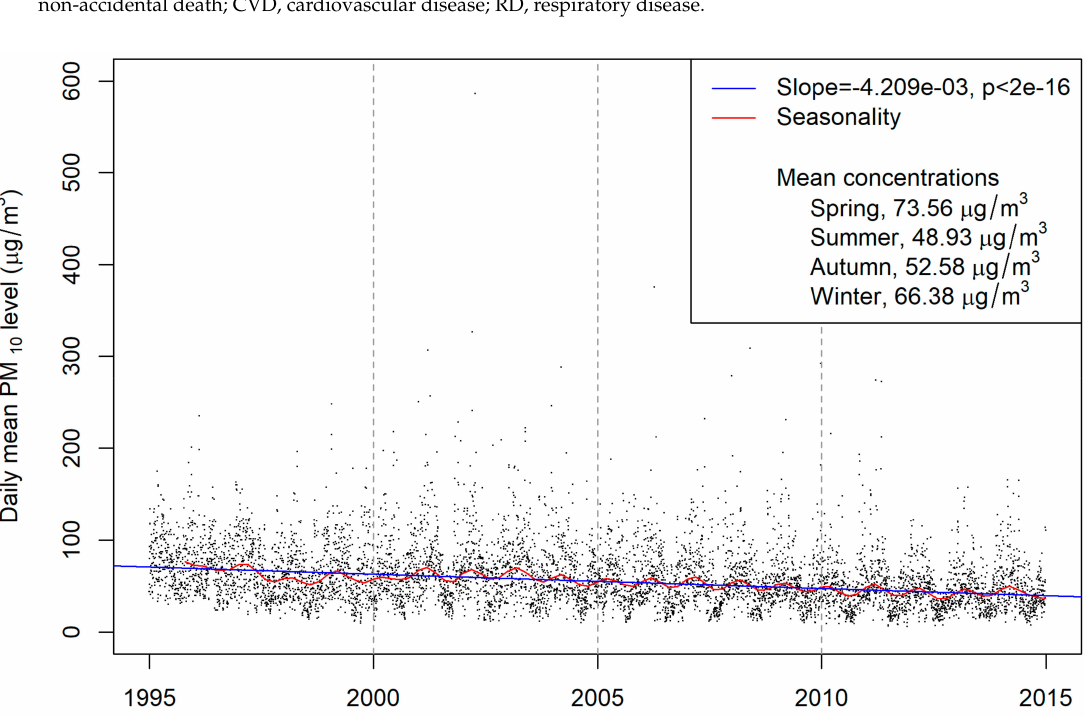
Figure 2. Time-series plot of daily mean particulate matter with an aerodynamic diameter of < 10 µ m (PM 10 ) concentrations in Seoul between 1 January 1995 and 31 December